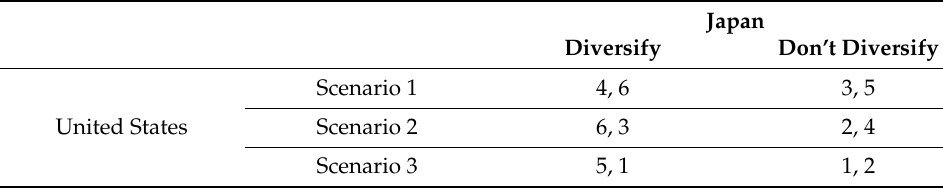
Table 5. Payoff matrix for sanction scenario 1 (Unsanctioned